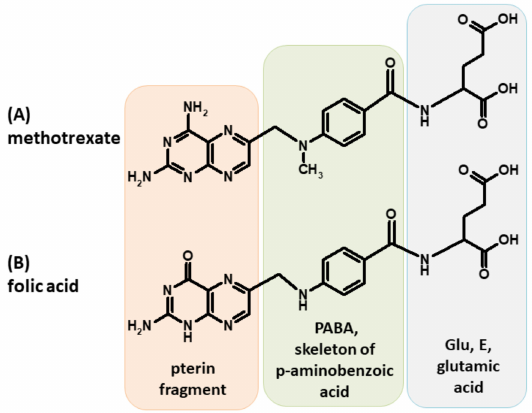
Figure 1. Molecular formulas of methotrexate ( A ) and folic acid ( B )